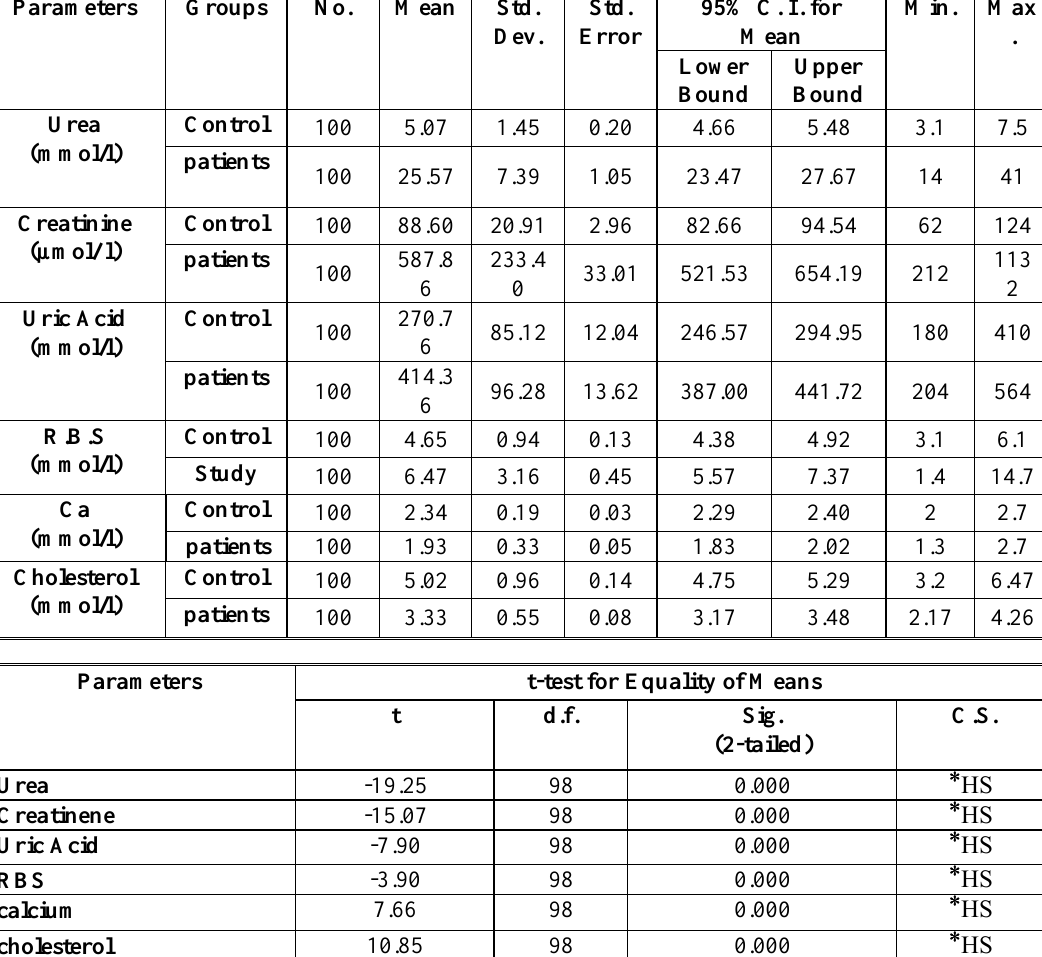
Table (3) Distribution of studied groups according to the mean concentration of urea , creatinine ,uric acid ,RBS, calcium and